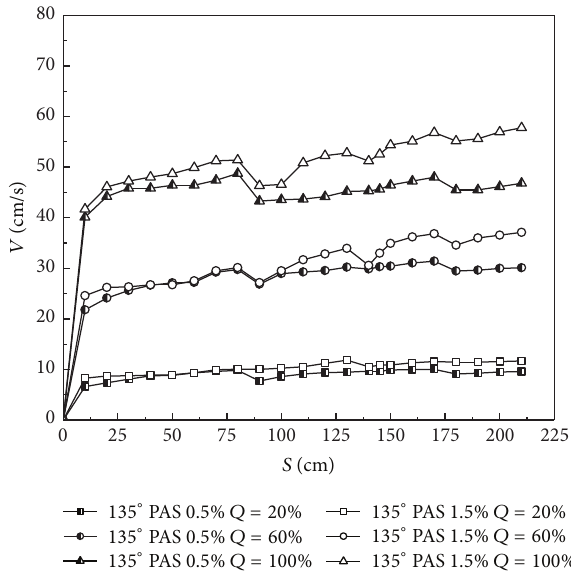
Figure 9: The PAS velocity-position diagram of various flow in 135 ∘